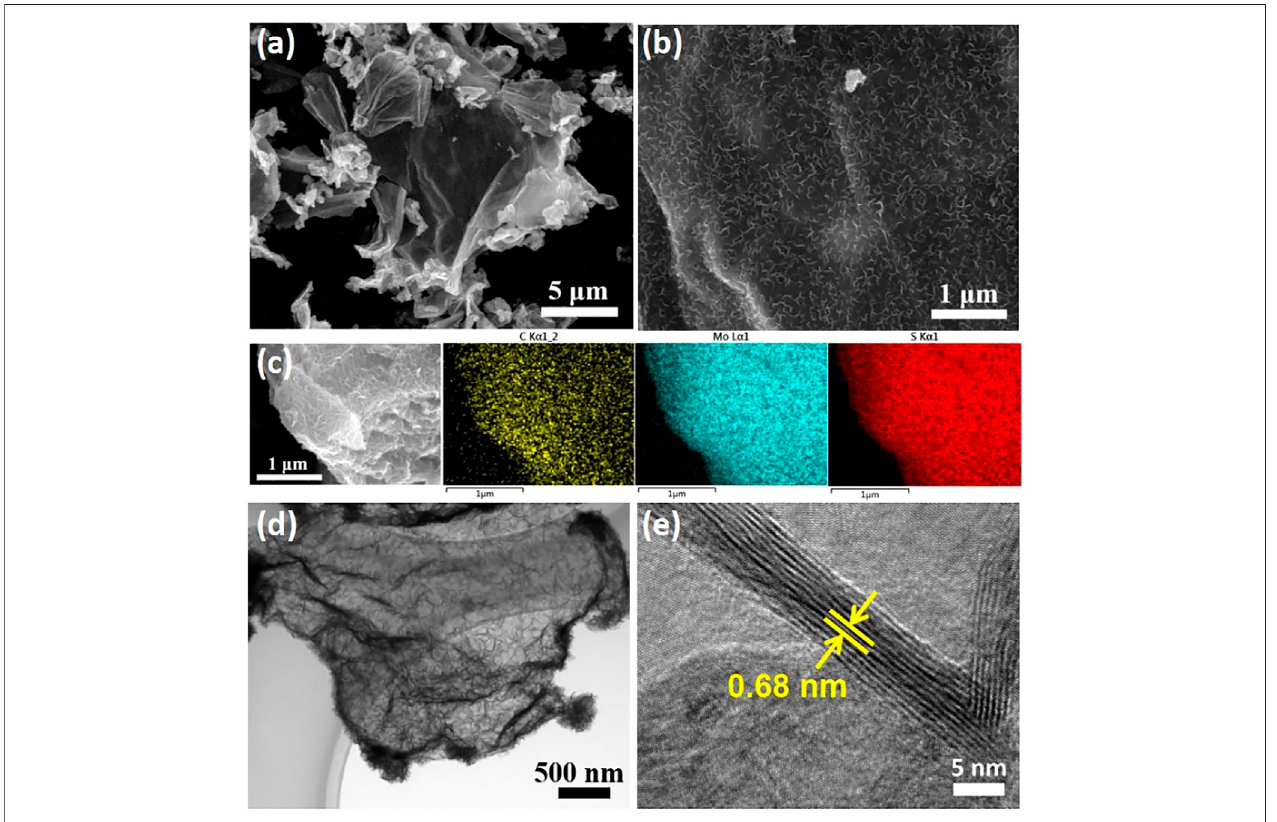
FIGURE 1 | (A,B) SEM images of the MoS 2 @rGO composite. (C) EDX elemental mapping of C, Mo, and S. (D) TEM and (E) HRTEM images of MoS 2 @rGO composite.